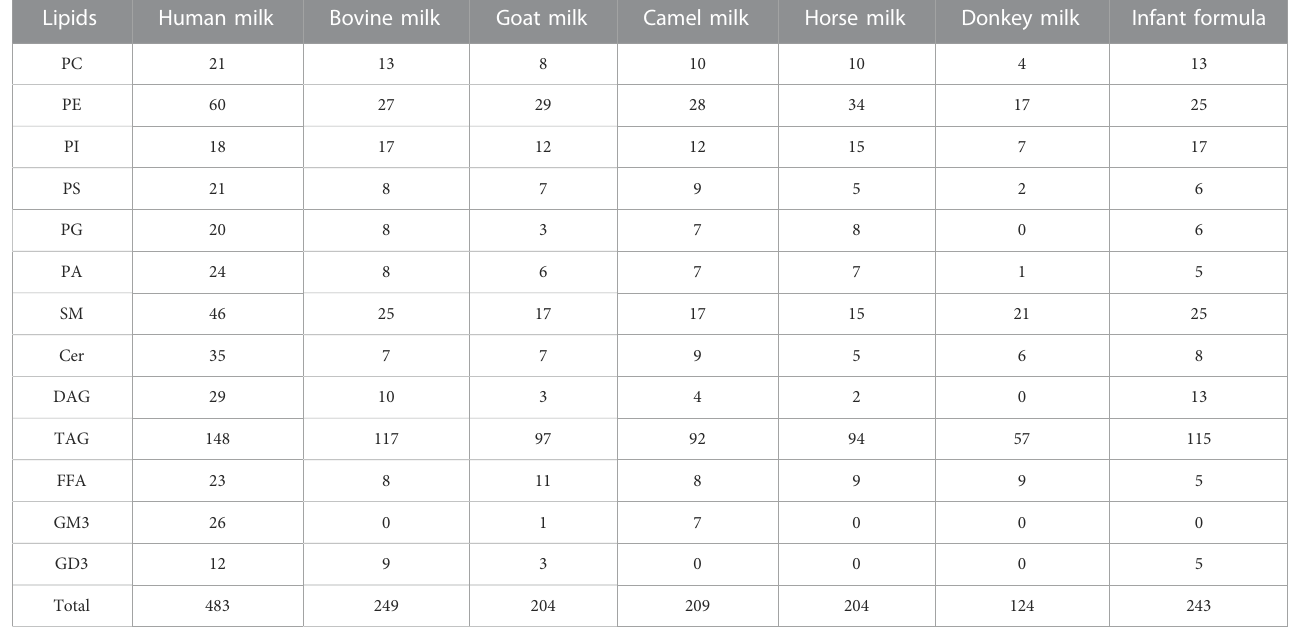
TABLE 5 The total species number of lipids in other mammalian milk and infant formula. Lipids Human milk Bovine milk Goat milk Camel milk Horse milk Donkey milk Infant